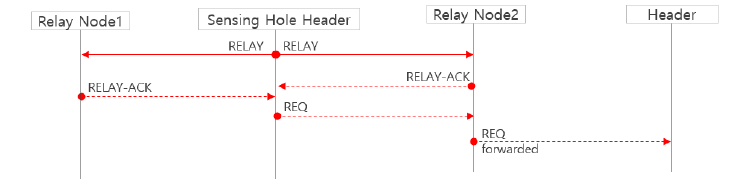
Figure 8. An attempt at recovering a sensing hole.